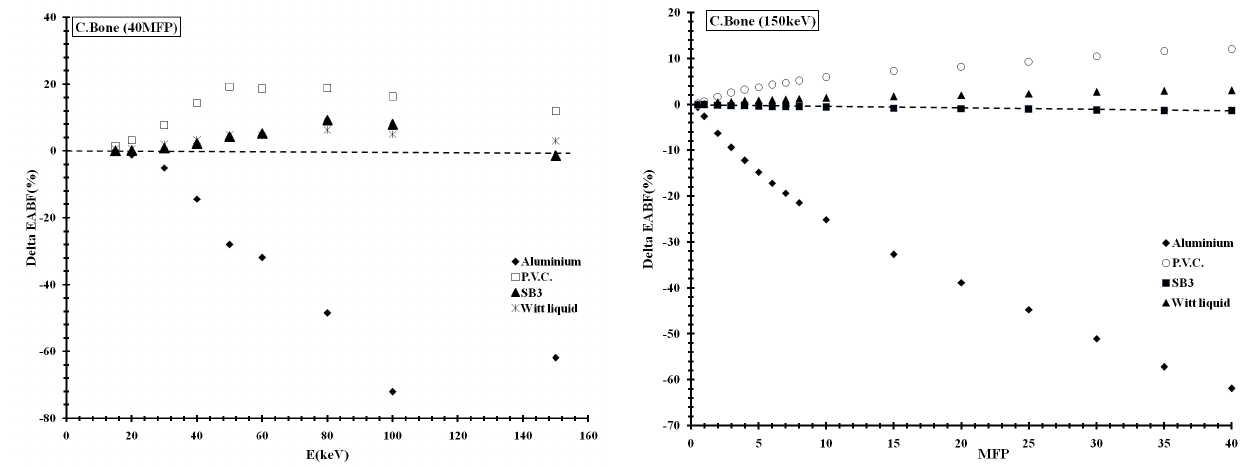
Figure 5. Relative deviation of energy absorption buildup factor of substitute materials to cortical bone tissue as a function of: ( left side) photon energy for fixed depths of 0.5, 15 and 40 mfp and ( right side) depth for fixed photon energy of 30, 80 and 150 keV.